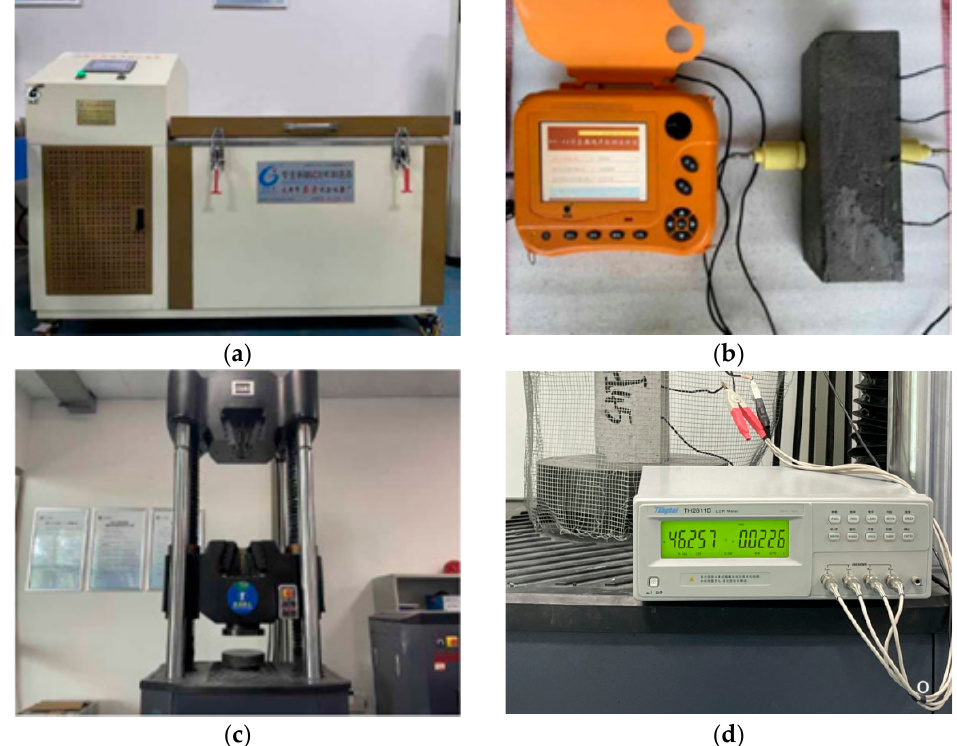
Figure 2. The test instruments: ( a ) freeze-thaw testing chamber; ( b ) ultrasonic detector; ( c ) MTS pressure testing machine; ( d ) LCR digital bridge.